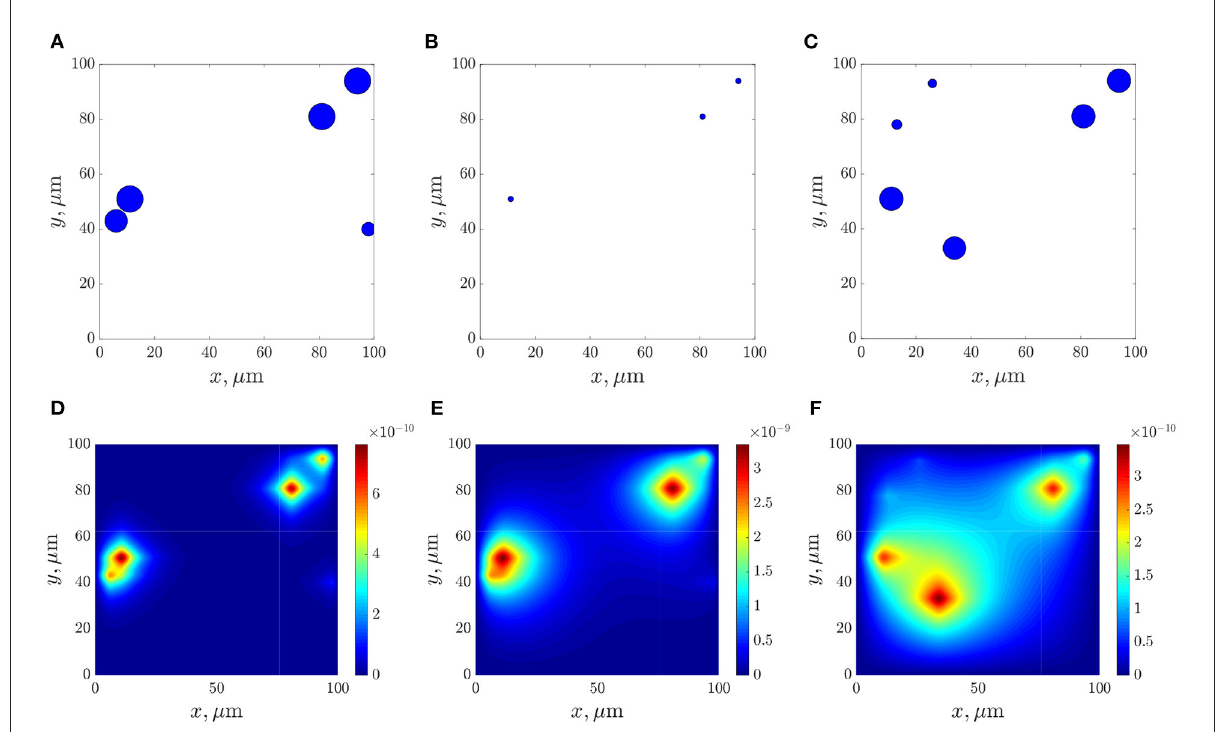
FIGURE10 The dynamics of bacterial population (A–C) , and the space distributions of the AHL concentration— (D–F) , calculated at the corresponding moments 5, 12, and 100 h.